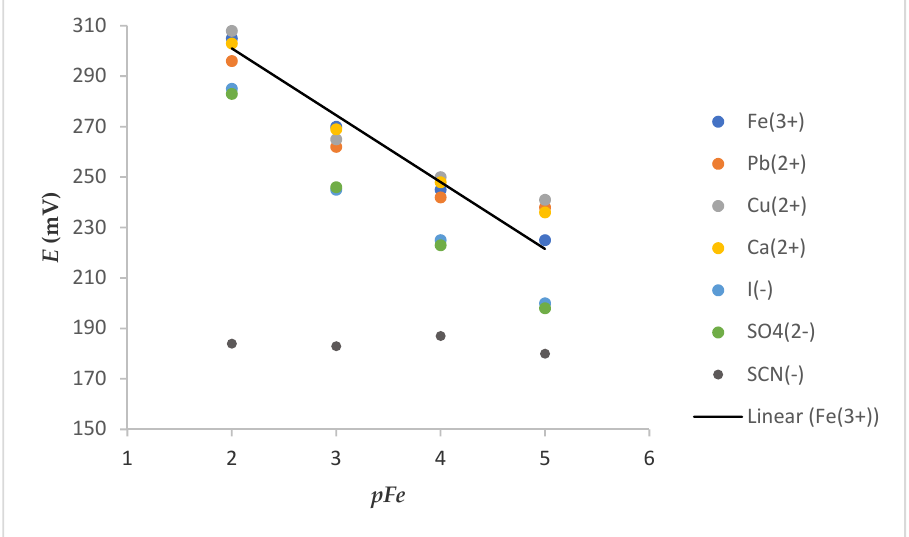
Figure 7. Dependence of E vs. pFe on electrode 7S (after washing Fe x O y NPs out) in the presence of a constant concentration of various cations or anions (c = 0.01 M).